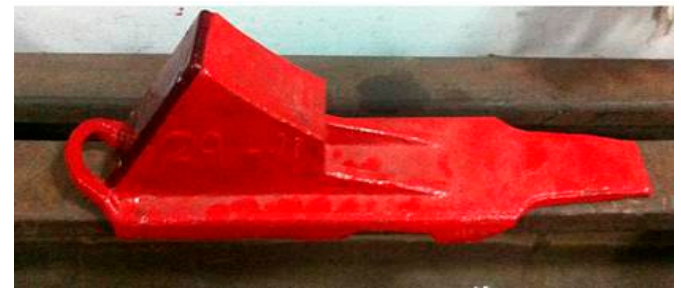
Figure 2. The terminal of intelligent track skate shell.